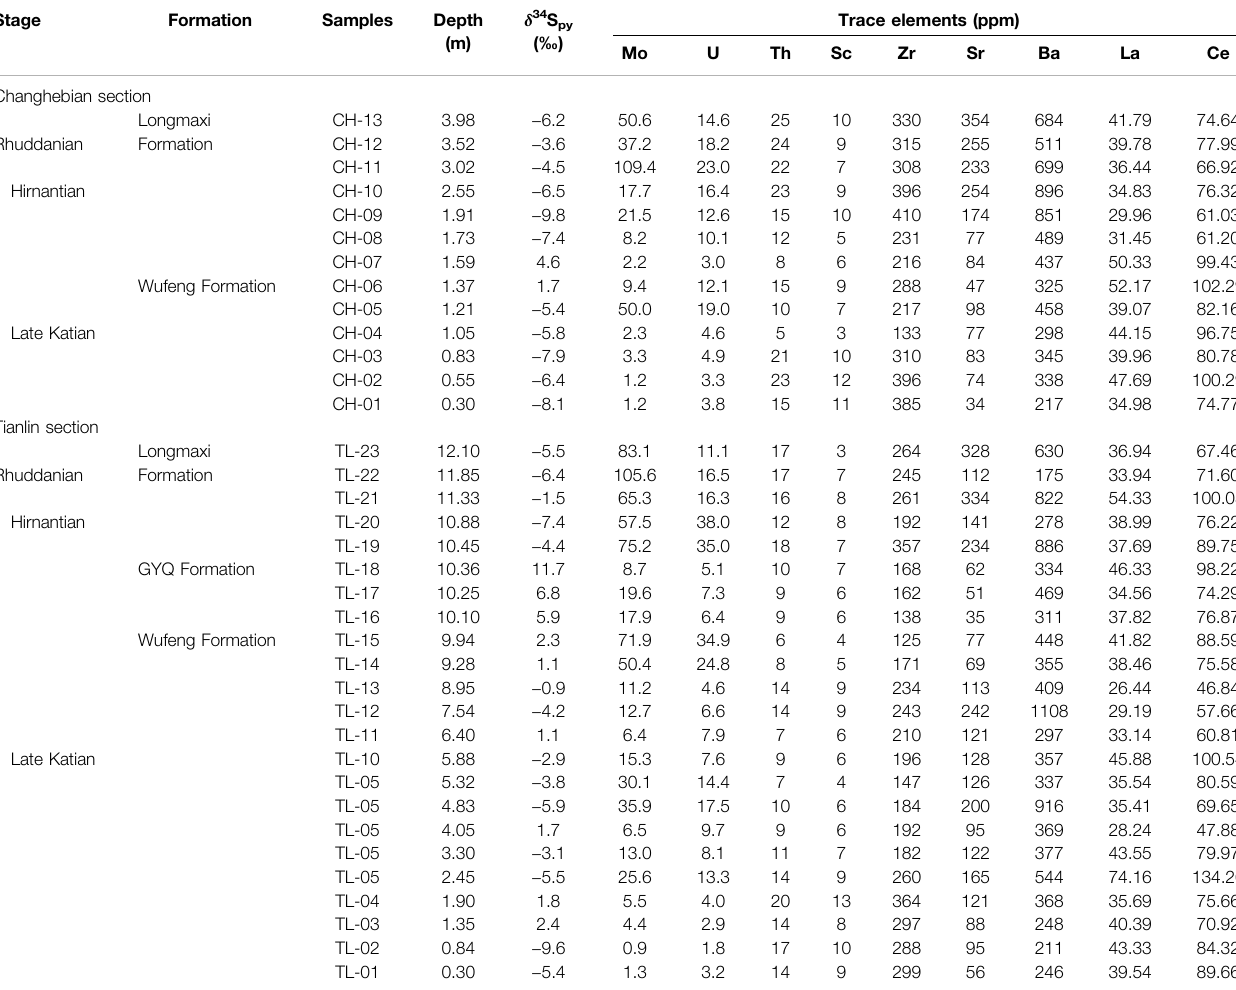
TABLE 2 | Results of trace elements and δ 34 S py in the Changhebian and Tianlin sections. Stage Formation